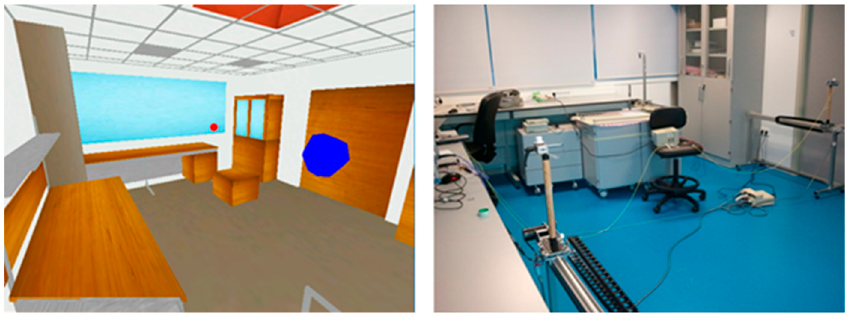
Figure 1. 3D model of the laboratory.